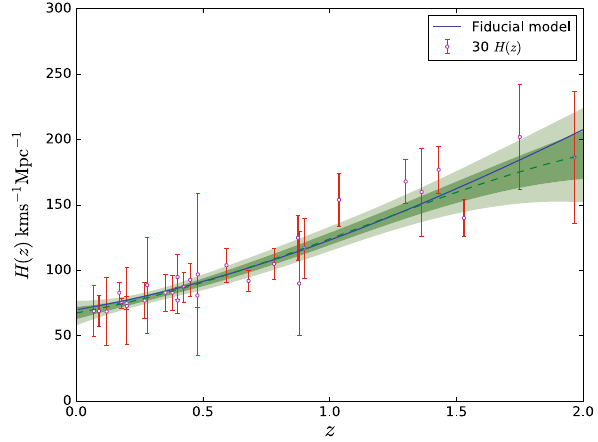
Fig. 2 Hubble parameter measurements from cosmic chronometers (red points) and the reconstruction of H ( z ) function (green envelope). Blue line corresponds to the fiducial cosmological model